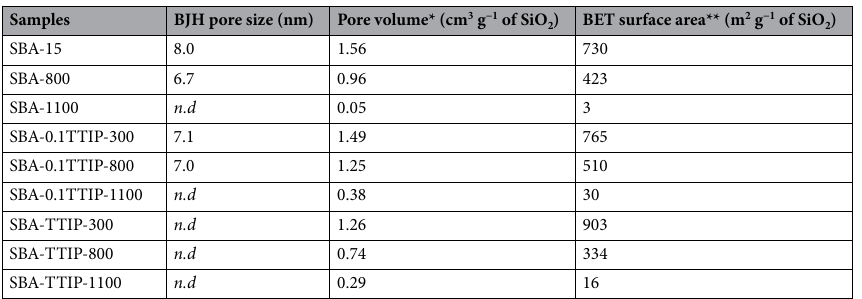
Table 1. The changes in the pore volume and BET surface area of SBA-15, SBA-TTIP and SBA-0.1TTIP by the heat treatment. *BET surface area and pore volume were converted to the value per gram of SiO 2 using the composition (35 and 72mass%) of SiO 2 in SBA-TTIP and SBA-0.1TTIP. n.d. not determined.